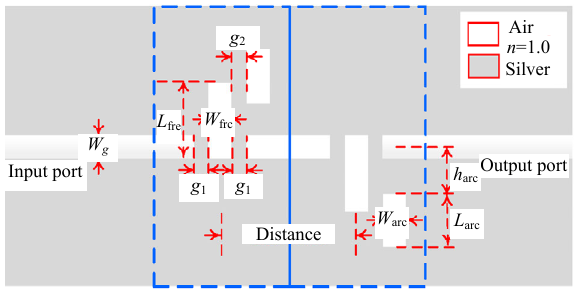
Fig. 1 Proposed cascade scheme using a dual-rectangular cavity system as building